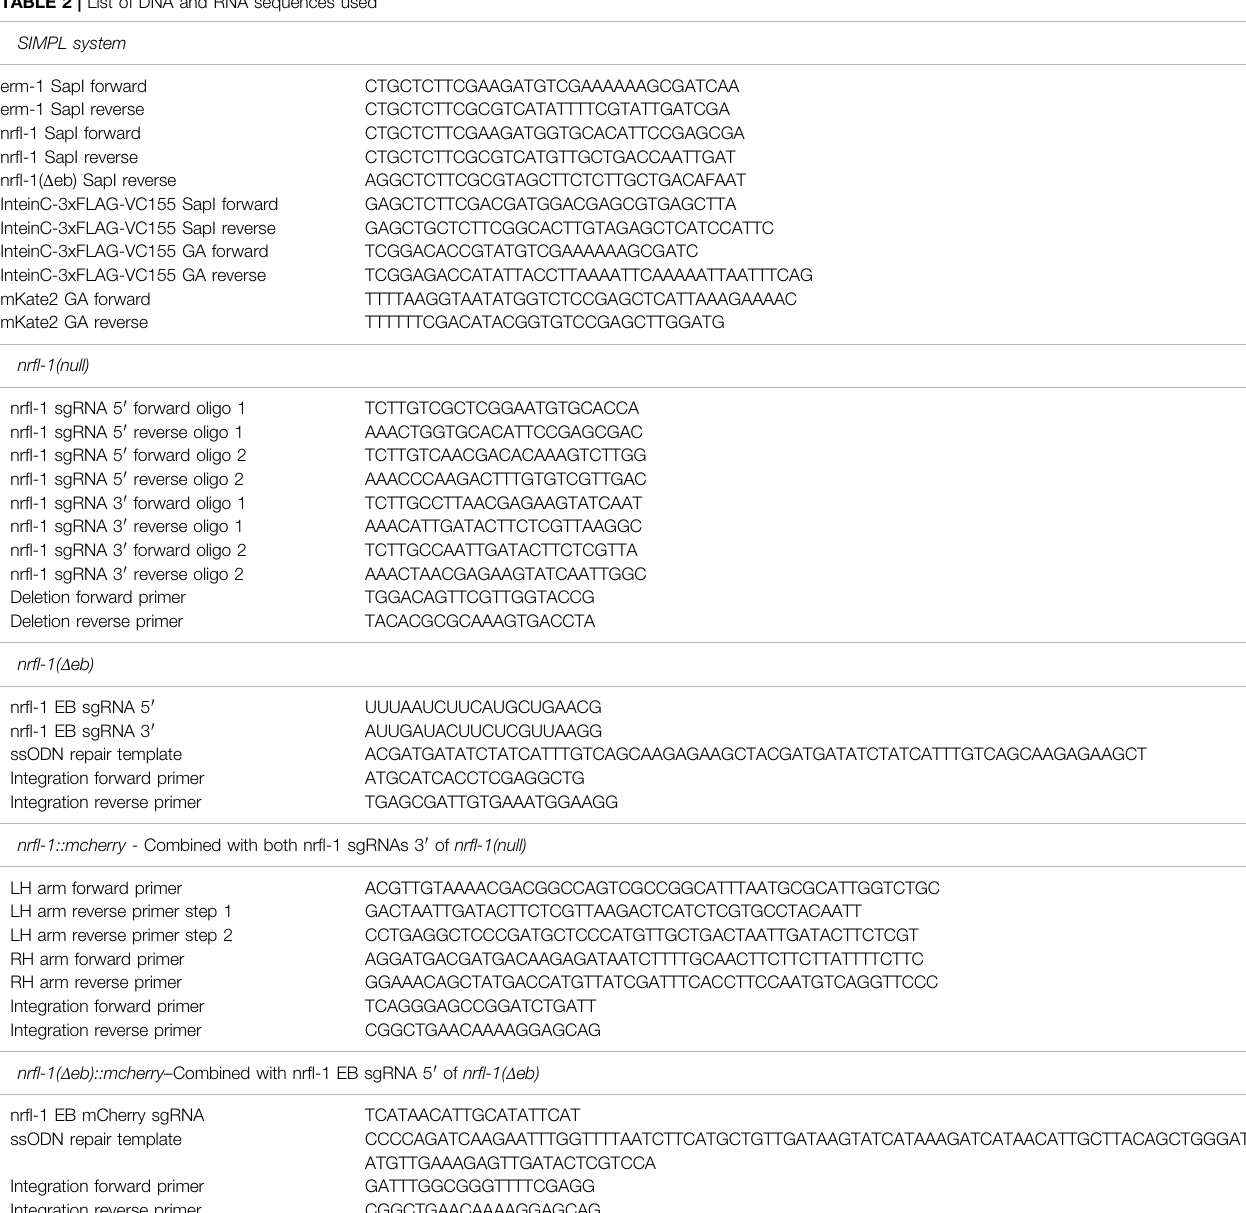
TABLE 2 | List of DNA and RNA sequences used SIMPL system erm-1 SapI